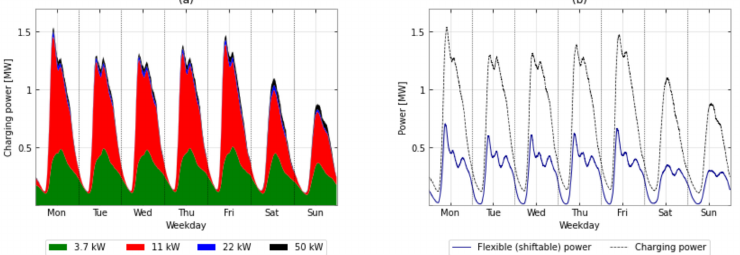
Figure A12. ( a ) User Group B: Charging power profile as a function of the assumed charging power used; ( b ) User Group B: Relation between the charging power profile and the associated flexible (shiftable)